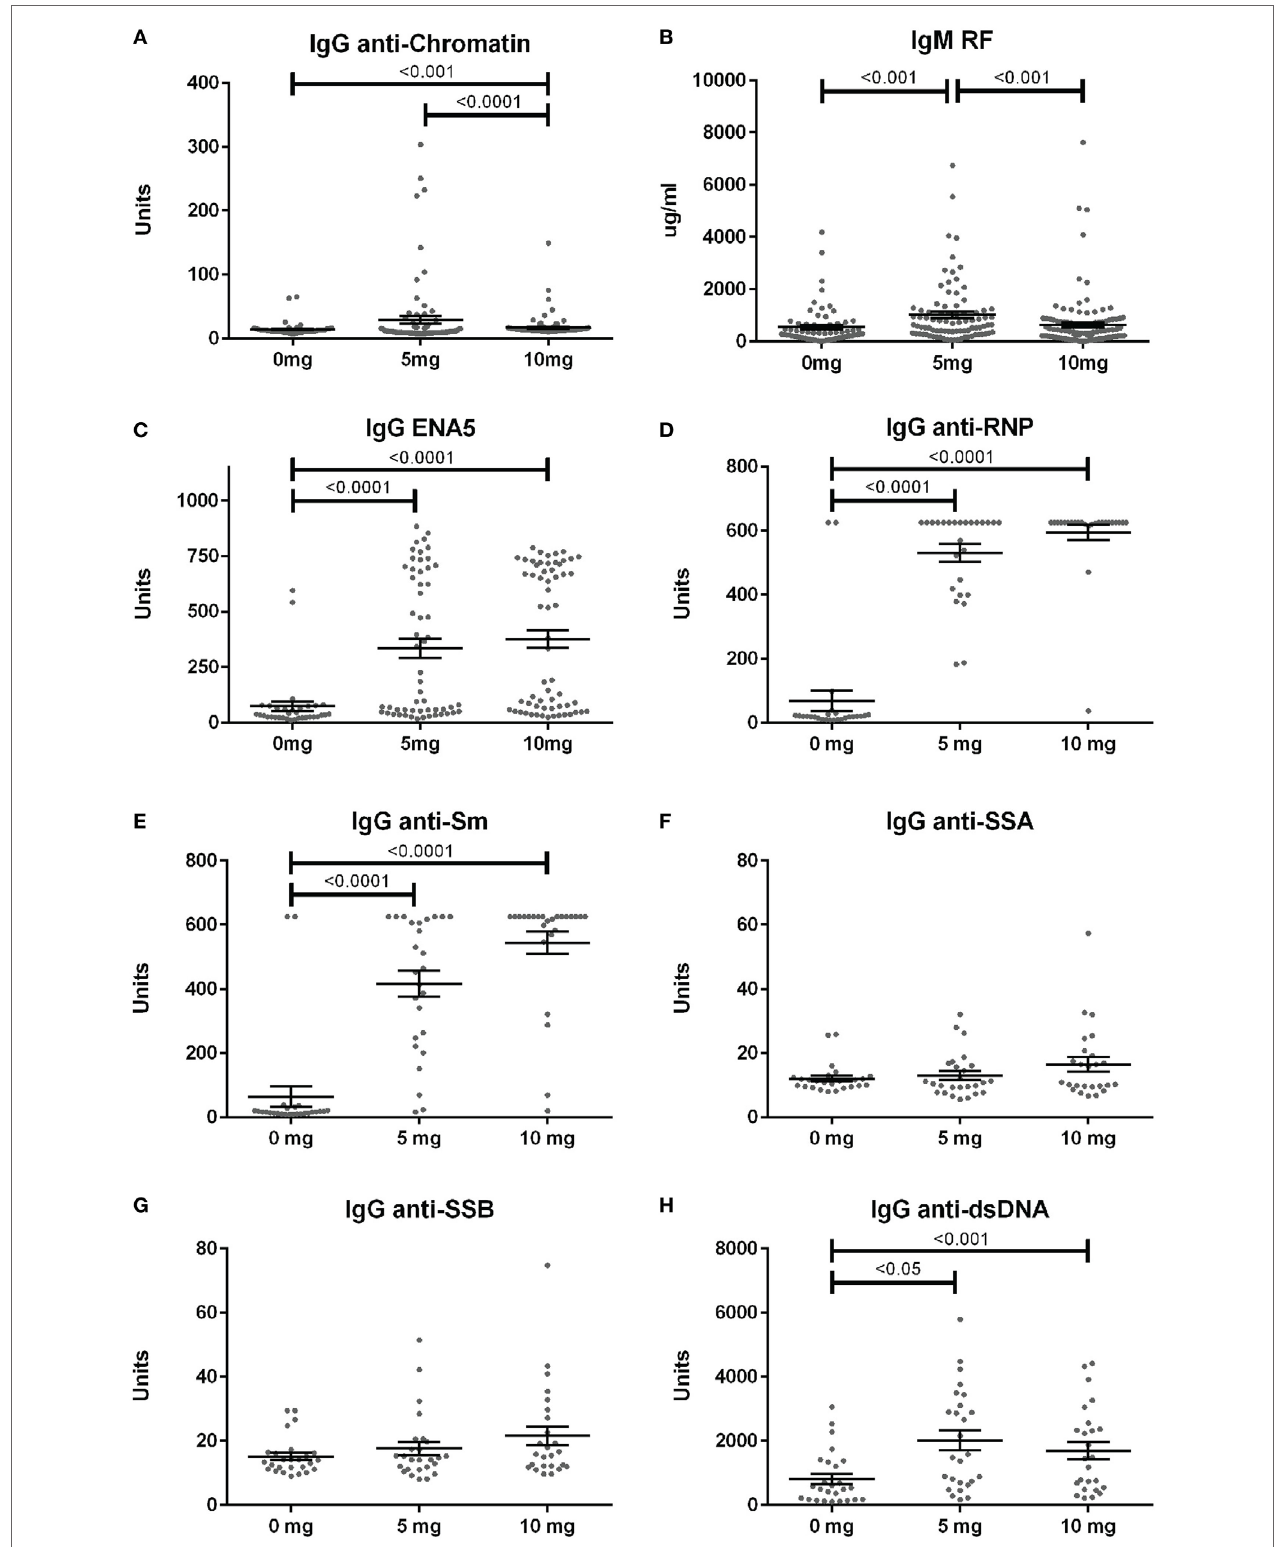
FigUre 4 | Serum autoantibodies in silica-exposed diversity outbred mice. Mice were exposed transorally to crystalline silica in PBS (see Figure 1 ) before blood was collected for determination of serum autoantibodies: (a) IgG anti-chromatin, (B) IgM rheumatoid factor, (c) ENA5 [designed for the detection of IgG anti-Sm, -RNP, -SSA (60 and 52 kDa), -SSB, and -Scl-70 IgG antibodies], (D) IgG anti-RNP, (e) IgG anti-Sm, (F) IgG anti-SSA, (g) IgG anti-SSB, and (h) IgG anti-dsDNA.